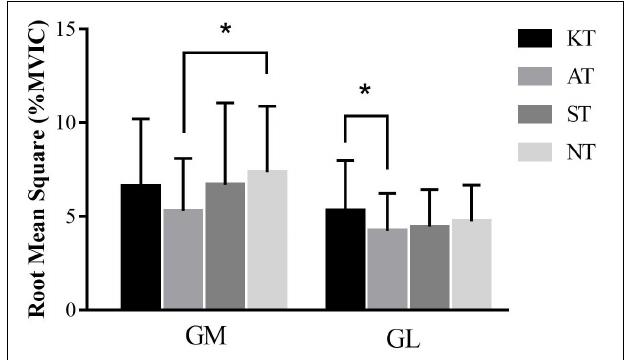
FIGURE 2 | Comparison of root mean square values (%MVIC) in condition 4 during sensory organization test for gastrocnemius medialis and gastrocnemius lateralis. *means significant difference during different taping treatments.